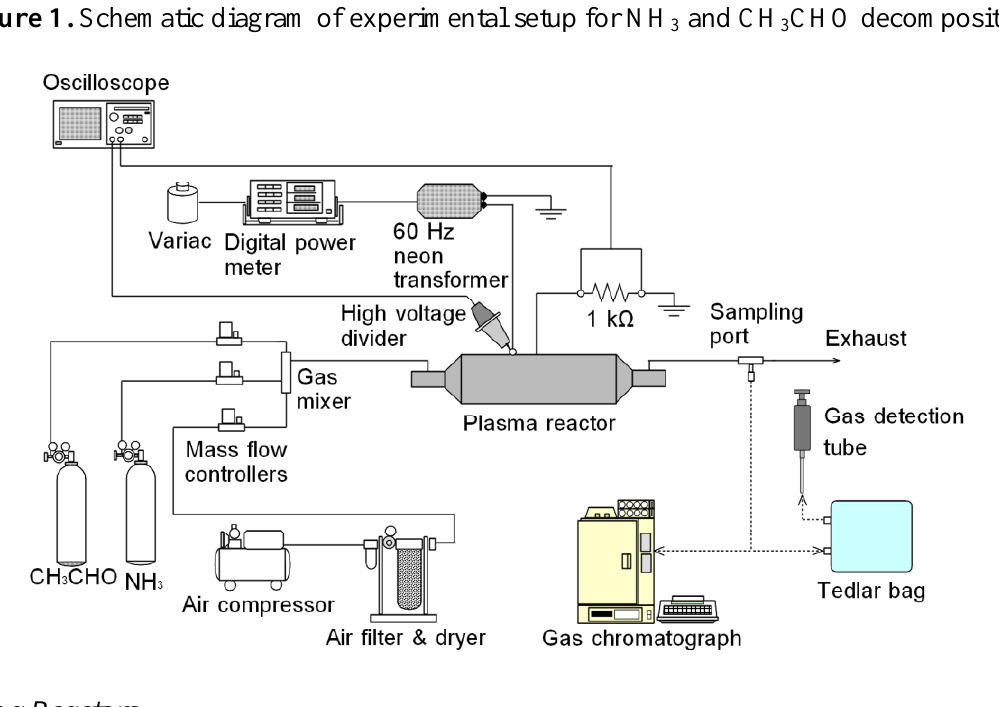
Figure 1. Schematic diagram of experimental setup for NH